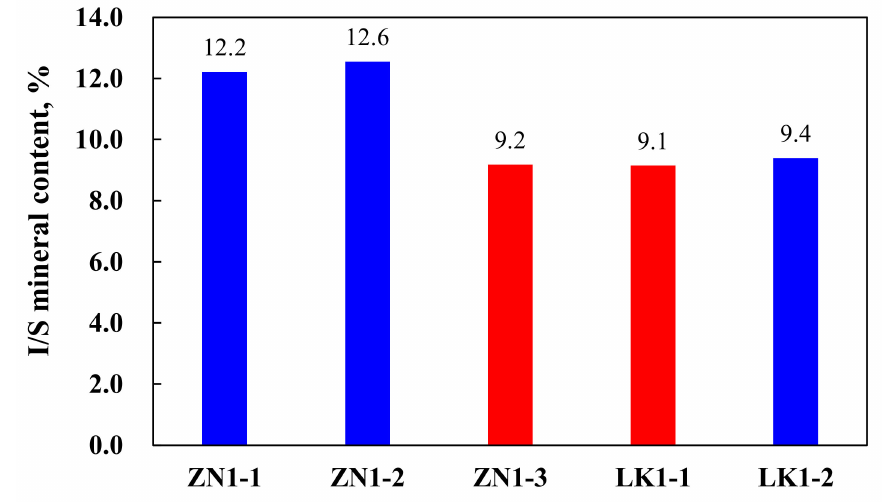
Figure 4. The I / S minerals content of di ff erent